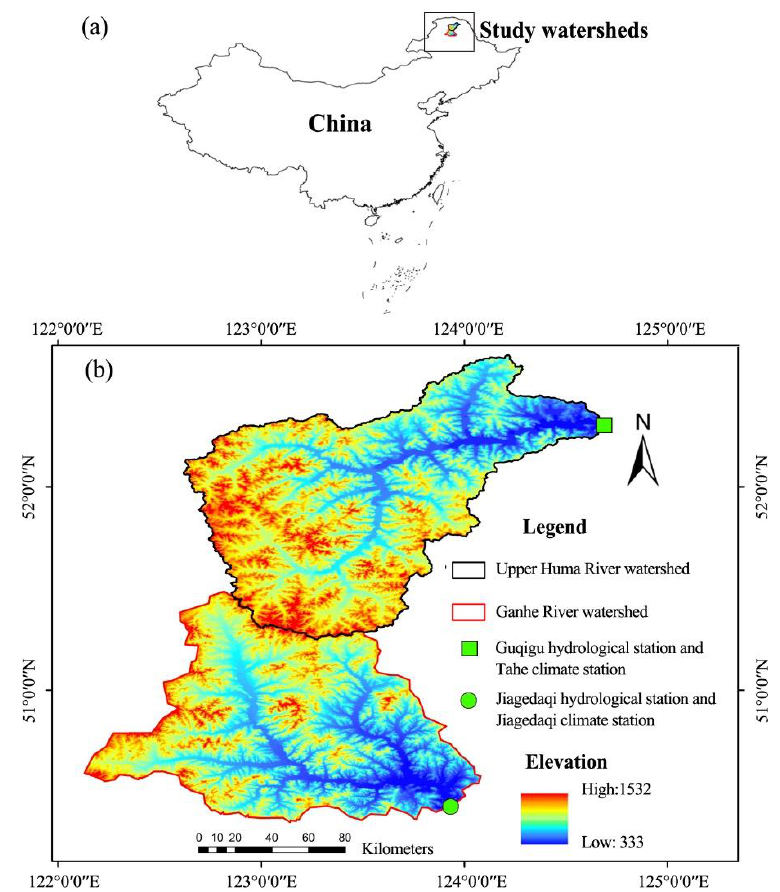
Figure 1. Location ( a ), topography and hydrometeorological stations ( b ) of the study watersheds.